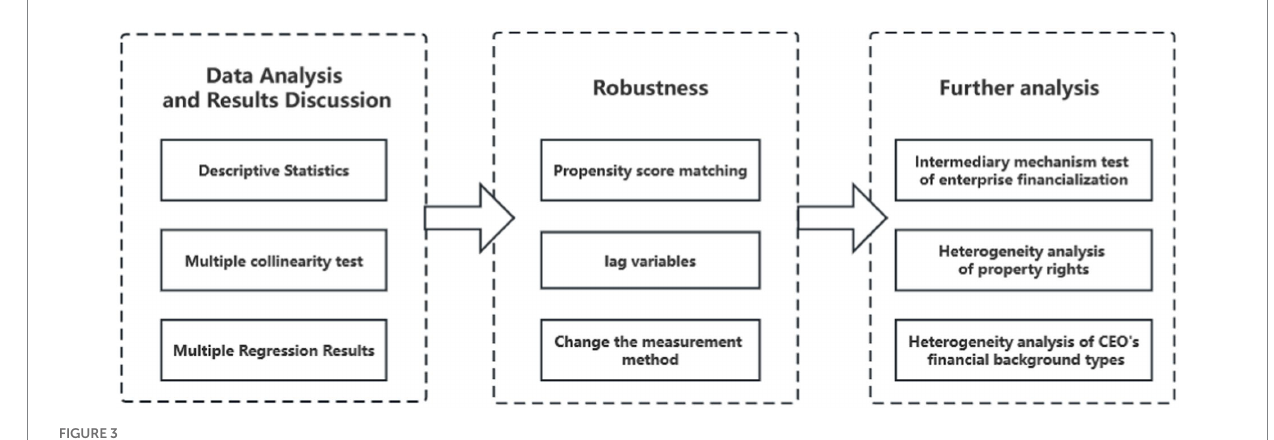
FIGURE 3 The process diagram of the